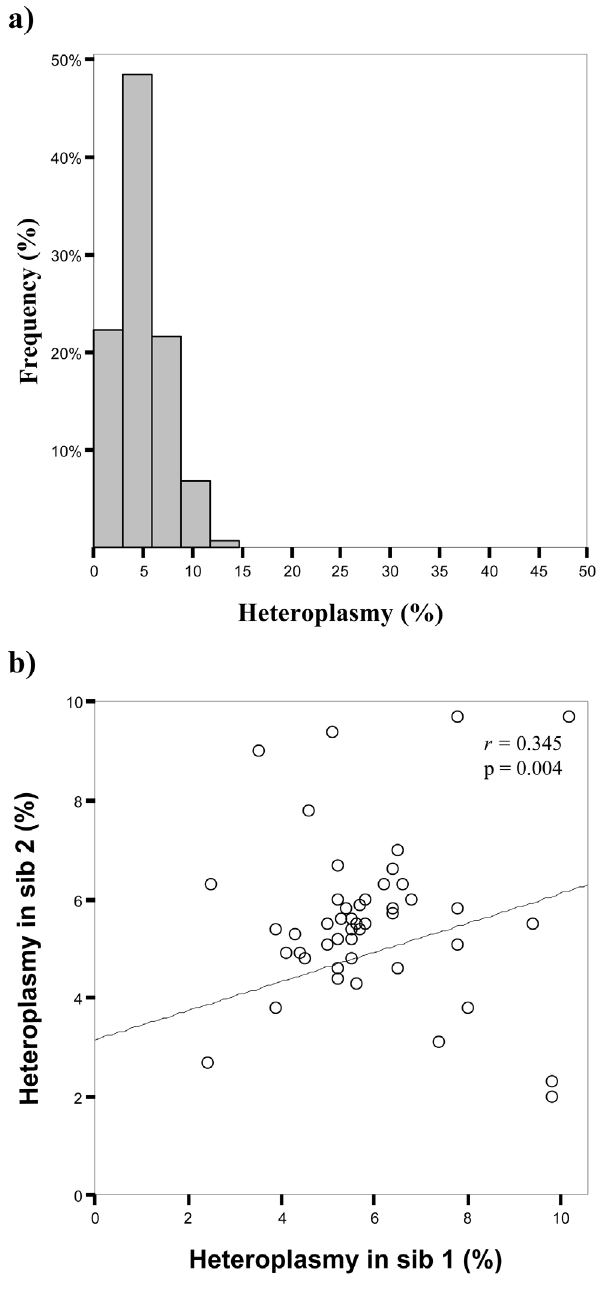
Figure 3. Heteroplasmy distribution (a) and correlation analyses (b) in Finnish sib-pairs. Percentages of heteroplasmy are estimated on a DHPLC reference curve [10]. In (b), regression analysis with correlation coefficients and p-values by 2-tailed Pearson test is shown.